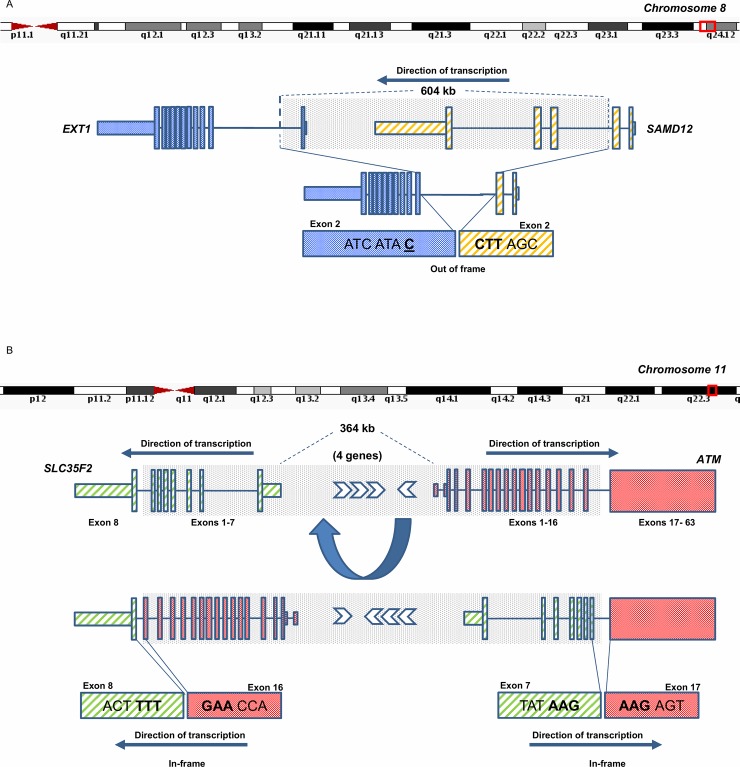
Diagnostic fusion transcripts identified by RNA-Seq in Mendelian disease cases.3A) A SAMD12-EXT1 fusion identified in Patient 37 whose phenotype included multiple exostoses. Multiple exostoses are most often attributed to autosomal dominant mutations in EXT1 and EXT2 but extensive clinical testing failed to identify any variants of interest in either gene. RNA-Seq identified a fusion candidate which might be explained by an interstitial deletion based on the genes’ orientation and position on chromosome 8 and would lead to loss of function of both EXT1 and SAMD12 due to loss of coding potential at the fusion boundary. Despite clinical aCGH and MLPA results initially indicating no deletion affecting the putatively conjoined genes, reevaluation of clinical aCGH results appeared suggestive of a mosaic deletion of approximately 604 kb at chr8:118960168–119569348. The deletion was subsequently validated by several orthogonal methods and determined to be diagnostic of the multiple exostoses phenotype. The SAMD12-EXT1 fusion was not detected by standard TopHat filters. 3B) Reciprocal ATM-SLC35F2 and SLC35F2-ATM fusions detected in Patient 6, with a severe combined immunodeficiency phenotype. The patient carried a paternally inherited pathogenic ATM variant for which a second hit was sought due to the autosomal recessive nature of ATM mutations. RNA-Seq revealed reciprocal fusions that were expected to retain their protein-coding potential but lead to aberrant ATM function based on the results of a novel flow cytometry assay. The fusions were experimentally validated by several orthogonal methods and shown to be maternally inherited, equating to compound heterozygous loss of ATM function which was classified as diagnostic of the patient phenotype. These reciprocal fusions were the only members of our validation panel that were detected by standard TopHat filters.